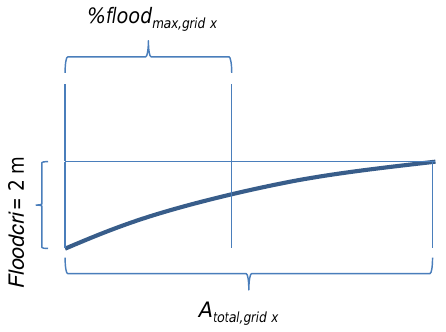
Figure 5. Schematic representation of the floodplain dynamics in the trunk version of ORCHIDEE. The bold line corresponds to the assumed shape of the floodplain. In ORCHILEAK, floodcri is re- placed by floodh 95th , which represent the 95th percentile of the wa- ter level above the floodplain (floodh) over the simulation period